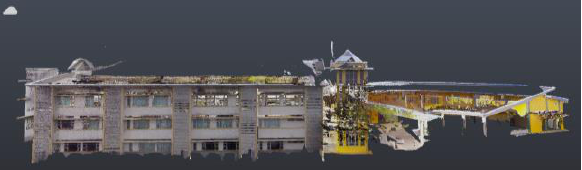
Figure 13 Front View of the building facades